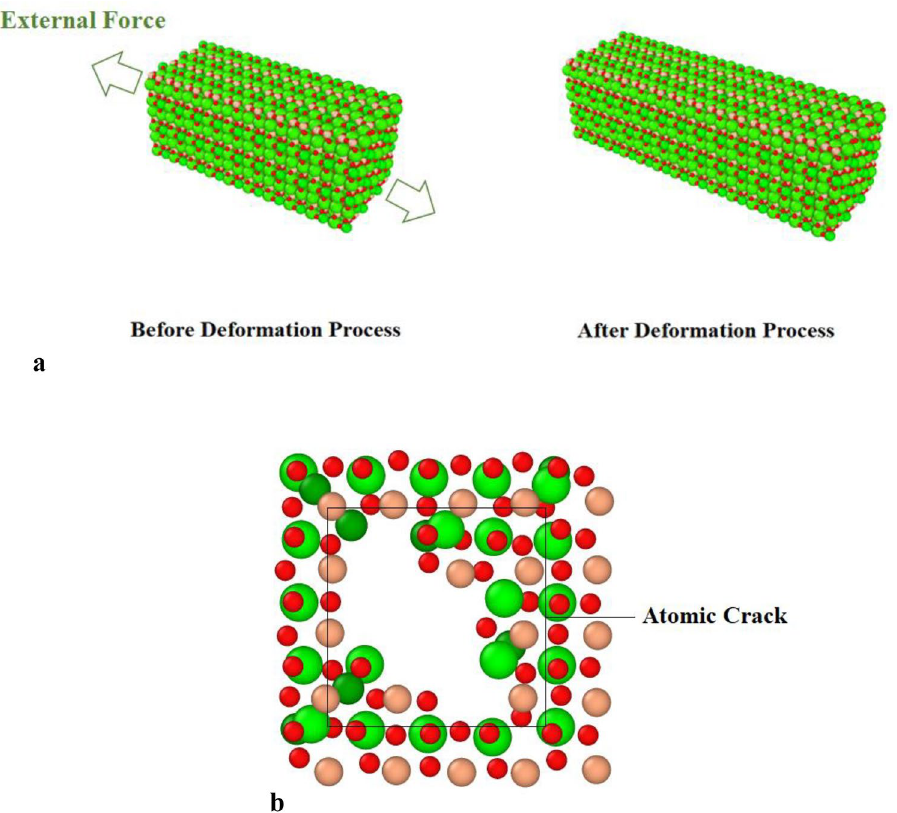
Figure 5. ( a ) The atomic arrangement of BAG-based nanostructure before and after the deformation. ( b ) Snapshot of atomic crack inside (middle region) nanostructure after deformation process done.